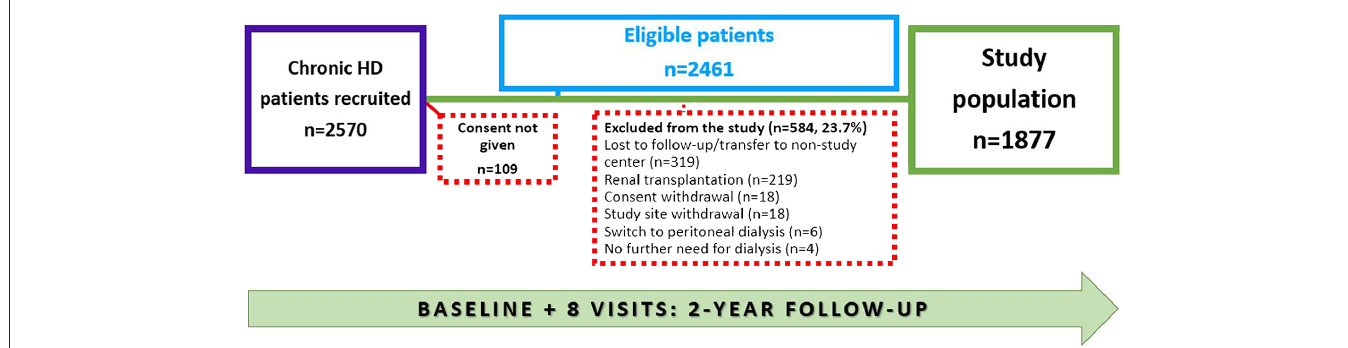
Figure 1. Flowchart of the study population from recruitment till the study end. HD,